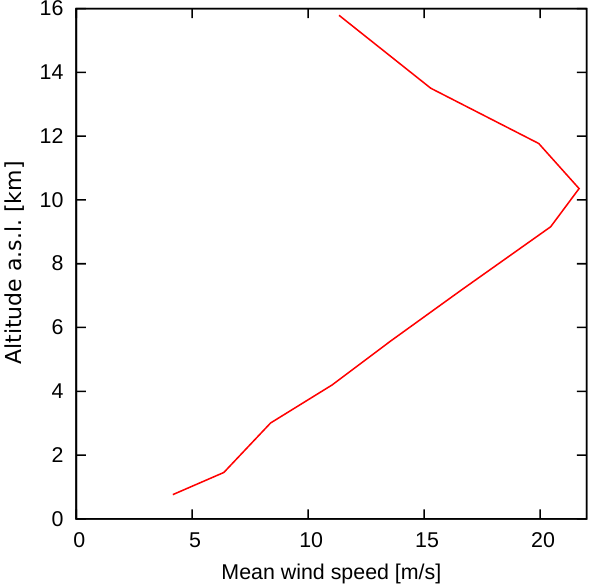
Figure 8. Short-term variability of the water vapor profile induced by local convection within a clearly confined upper edge of the boundary layer at 3.5km under stable atmospheric conditions. The variations do not exceed a factor of 2. The example error bars ( ± 2 σ ) represent statistical uncertainties caused by electronic noise in the